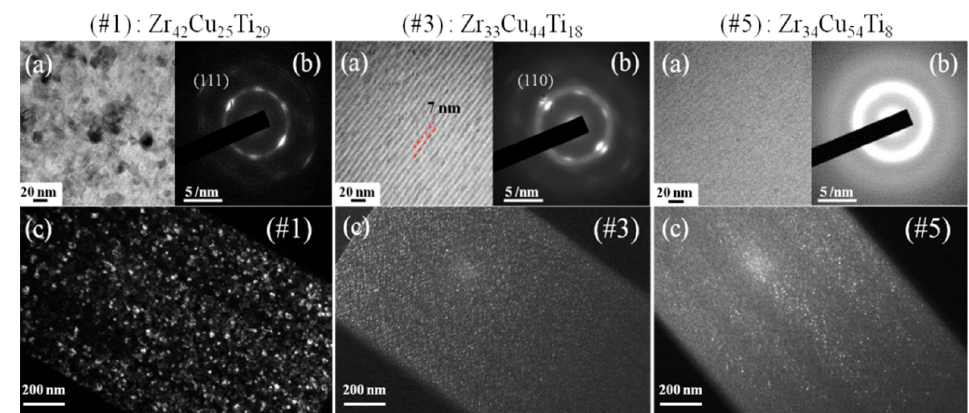
Figure 4. ( a ) Bright-field TEM images, ( b ) SAED, and ( c ) dark-field TEM images of Zr 42 Cu 25 Ti 29 (#1), Zr 33 Cu 44 Ti 18 (#3), and Zr 34 Cu 54 Ti 8 (#5) coatings.